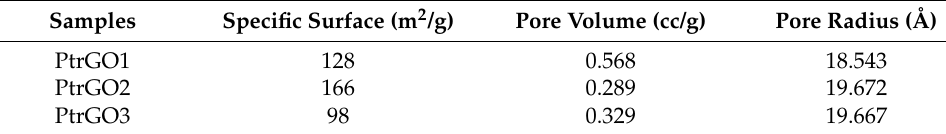
Table 3. BJH desorption summary [34].